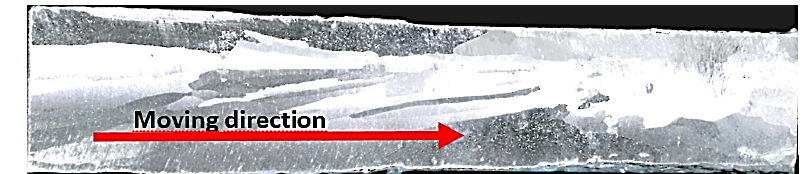
Figure 12. Macrograph of the longitudinal section, in the position at the middle of the bar (done using Barker’sreagent for 30 s at room temperature).